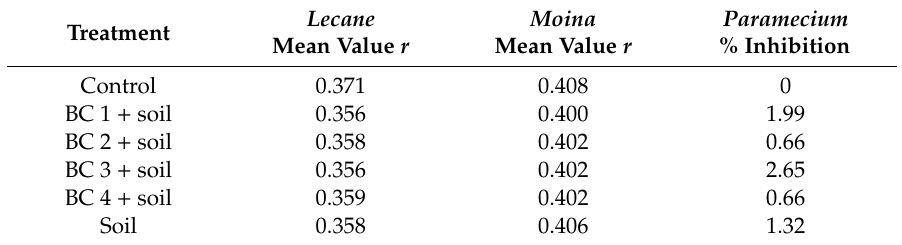
Table 10. Results of the growth inhibition and reproductive tests with Lecane quadridentata (Lecane), Moina macrocopa (Moina), and Paramecium caudatum (Paramecium) exposed to the BC:soil (1:8) elutriate. n =